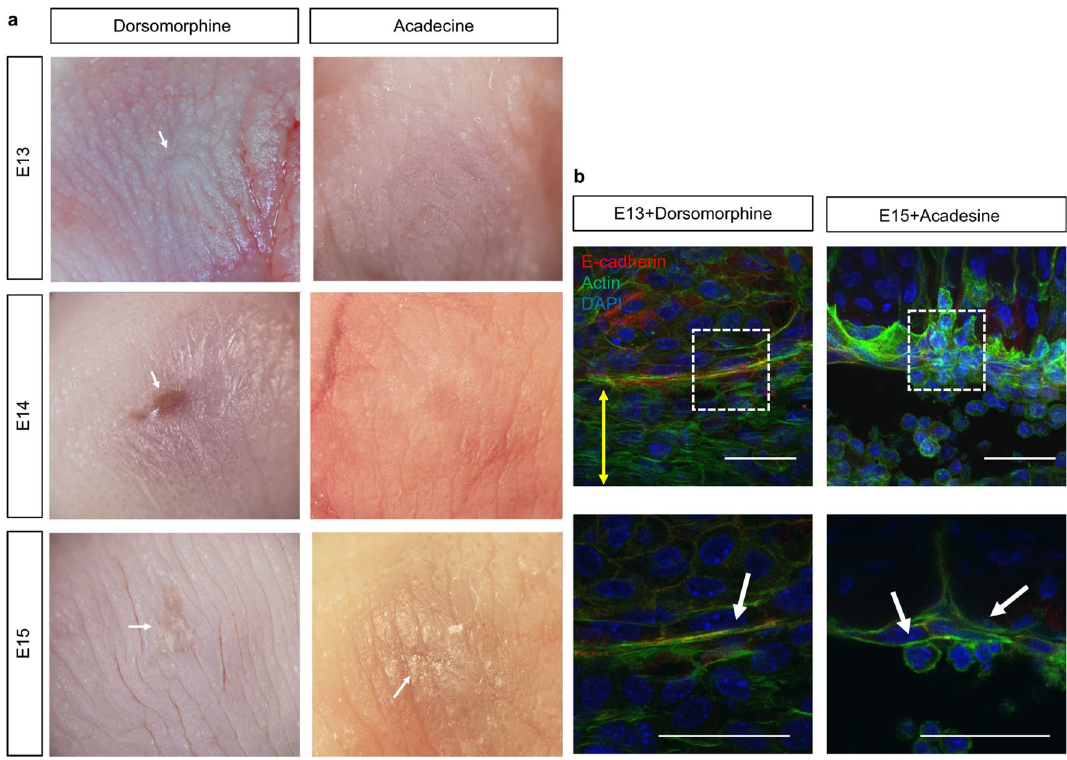
Figure 7. Effect of AMPK activity on wound healing in utero. ( a ) Effect of AMPK activity on wound healing 72 h after injury in E13, E14, and E15 wounds. Complete skin regeneration was observed in the AMPK activation group in E14 wounds. Arrow; visible mark. ( b ) In vivo regulation of AMPK activity and actin cable formation in E13 and E15 wounds. Yellow arrows indicate the wound area, and the white arrows indicate actin cables. Upper bar = 50 µm, lower bar = 20